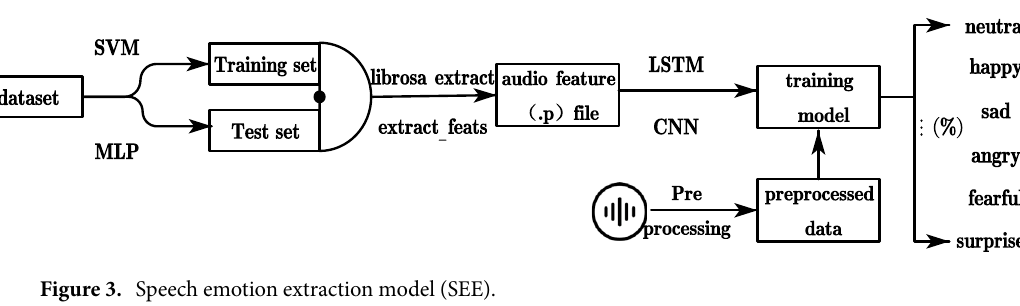
Figure 3. Speech emotion extraction model